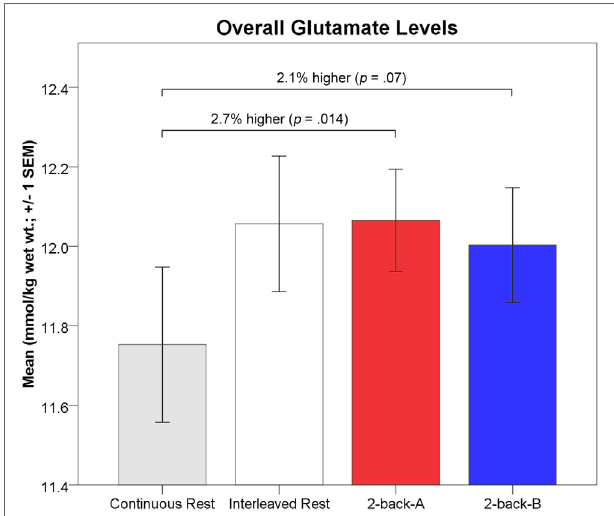
FigUre 6 | Absolute glutamate levels (mmol/kg wet wt. ± 1 SEM) for each task phase are depicted. Mean 2-back-A glutamate levels (red) were significantly higher (2.7%; 0.32 mmol/kg wet wt.) than continuous passive visual fixation glutamate levels (gray). Mean 2-back-B glutamate levels (blue) were non-significantly higher (2.1%; 0.25 mmol/kg wet wt.; p = 0.07) than continuous passive visual fixation glutamate levels (gray). Mean interleaved visual fixation glutamate levels (white) did not differ from 2-back